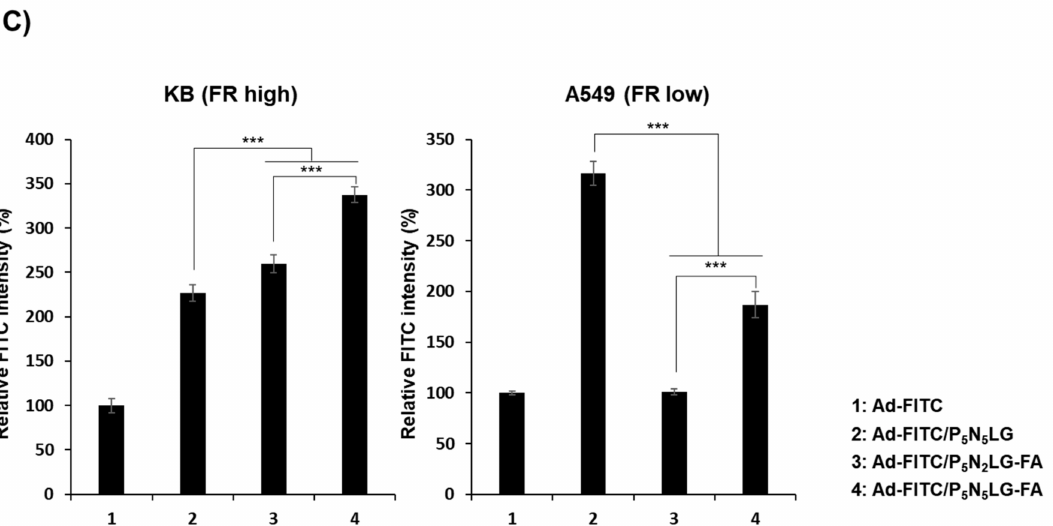
Figure 5. Cell uptake mechanism of Ad nanocomplexes. Competition assay with ( A ) FA or ( B ) CAR-specific Ab. KB cells were pretreated with FA or CAR-specific Ab, along with PBS as negative control, and then transduced with naked Ad, Ad/P 5 N 5 LG, Ad/P 5 N 2 LG-FA, or Ad/P 5 N 5 LG-FA. At 48 h post treatment, transduction efficiency was analyzed by fluorescence microscope and flow cytometry. The data are representatives of three independent experiments performed in triplicate. Bars represent mean ± SD. *** p < 0.001. ( C ) Cellular uptake efficiency of Ad and Ad nanocomplexes in KB (FR-high) and A549 (FR-low) cells. The cancer cells were treated with FITC-labeled samples (Ad-FITC, Ad-FITC/P 5 N 5 LG, Ad-FITC/P 5 N 2 LG-FA, or Ad-FITC/P 5 N 5 LG-FA) for 2 h at 37 ◦ C, then the FITC expression level in cancer cells were analyzed by flow cytometry. The data are representatives of three independent experiments performed in triplicate. Bars represent mean ± SD. *** p < 0.001. Original magnification rate: × 40. Scale bar is indicative of 1